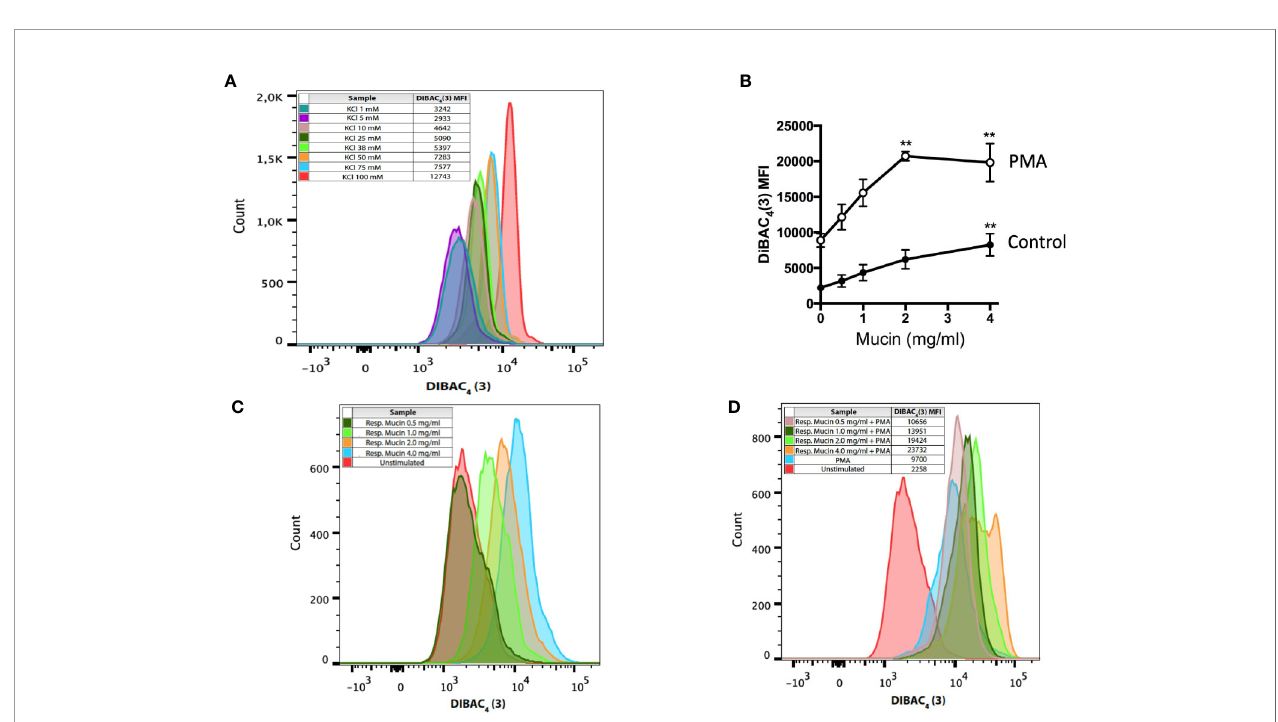
FIGURE 5 | Respiratory mucins promote and potentiate PMA-induced neutrophil membrane depolarization. (A) Neutrophils were exposed to graded K + concentrations. Membrane depolarization is indicated by the shift in the intensity of DiBAC4(3) fl uorescence. Graded potassium solutions were made by increasing the KCl concentration in the solution. For graded K + solutions, the KCl concentration was set to 1, 5, 10, 25, 38, 50, 75, and 100 mM. (B) Human neutrophils were incubated in the presence of respiratory mucins ( (cid:129) , 0.5 – 4 mg/ml) or stimulated with 200 nM PMA in the presence of respiratory mucins (<). After a 20-min incubation,